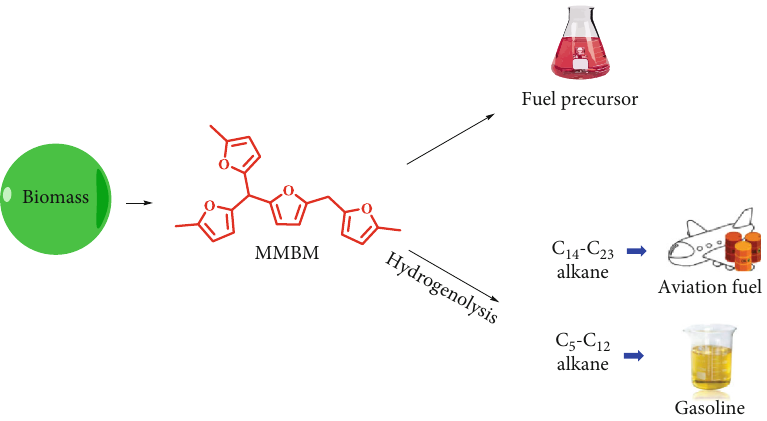
Scheme 1: The production and application of biomass-based C